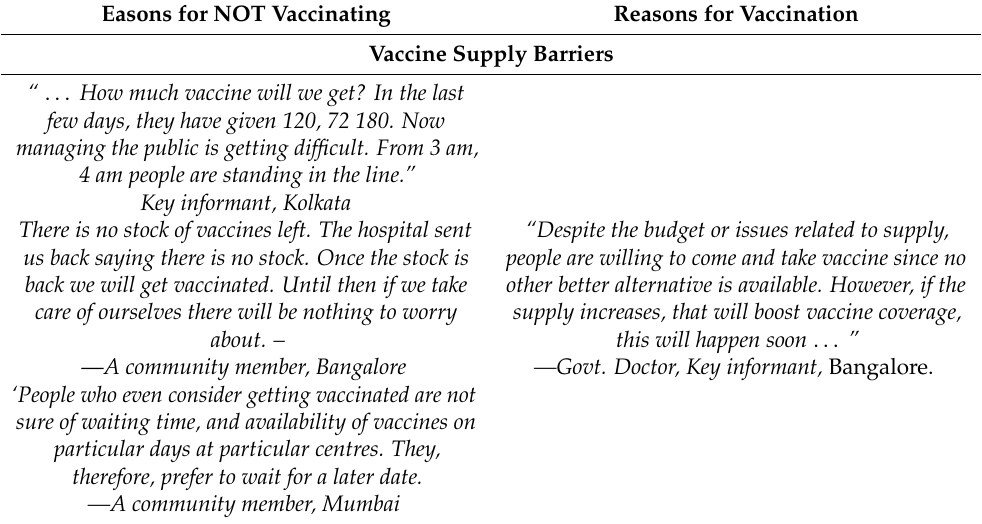
Table 16. Description of theme vaccine supply issues. Easons for NOT Vaccinating